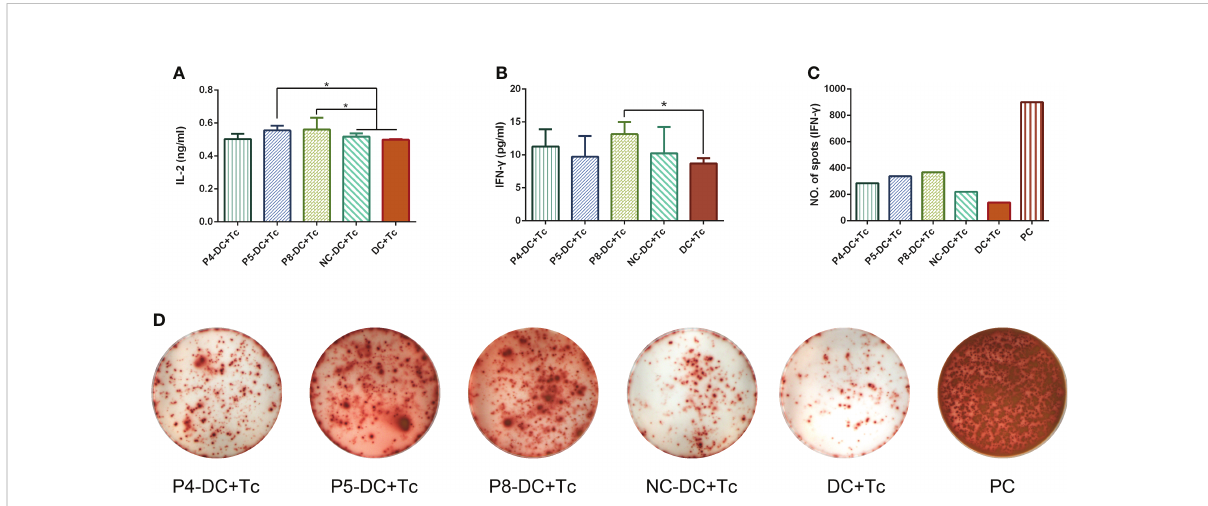
FIGURE 5 MAGE-D4 peptide pulsed DCs stimulated T cells secreting cytokines. (A) ELISA detected IL-2. (B) ELISA detected IFN- g . (C, D) ELISOT detected number of T cells secreting IFN- g . DC, dendritic cell; NC, negative control peptide; Tc,T cell. PC, positive control. *P